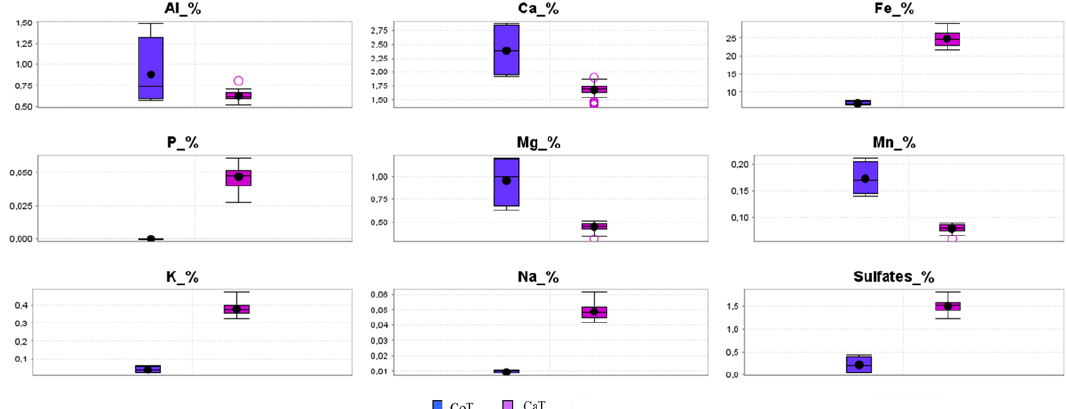
Figure 3. Basic statistics and comparison of major element (%log) for the two sets of tailings samples.